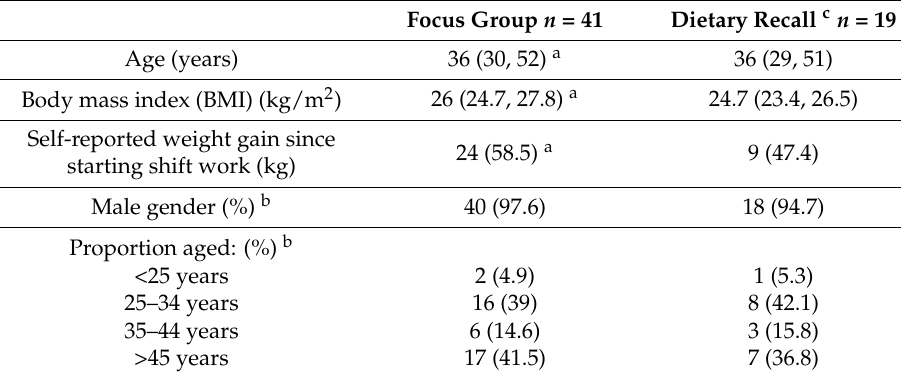
Table 2. Characteristics of study